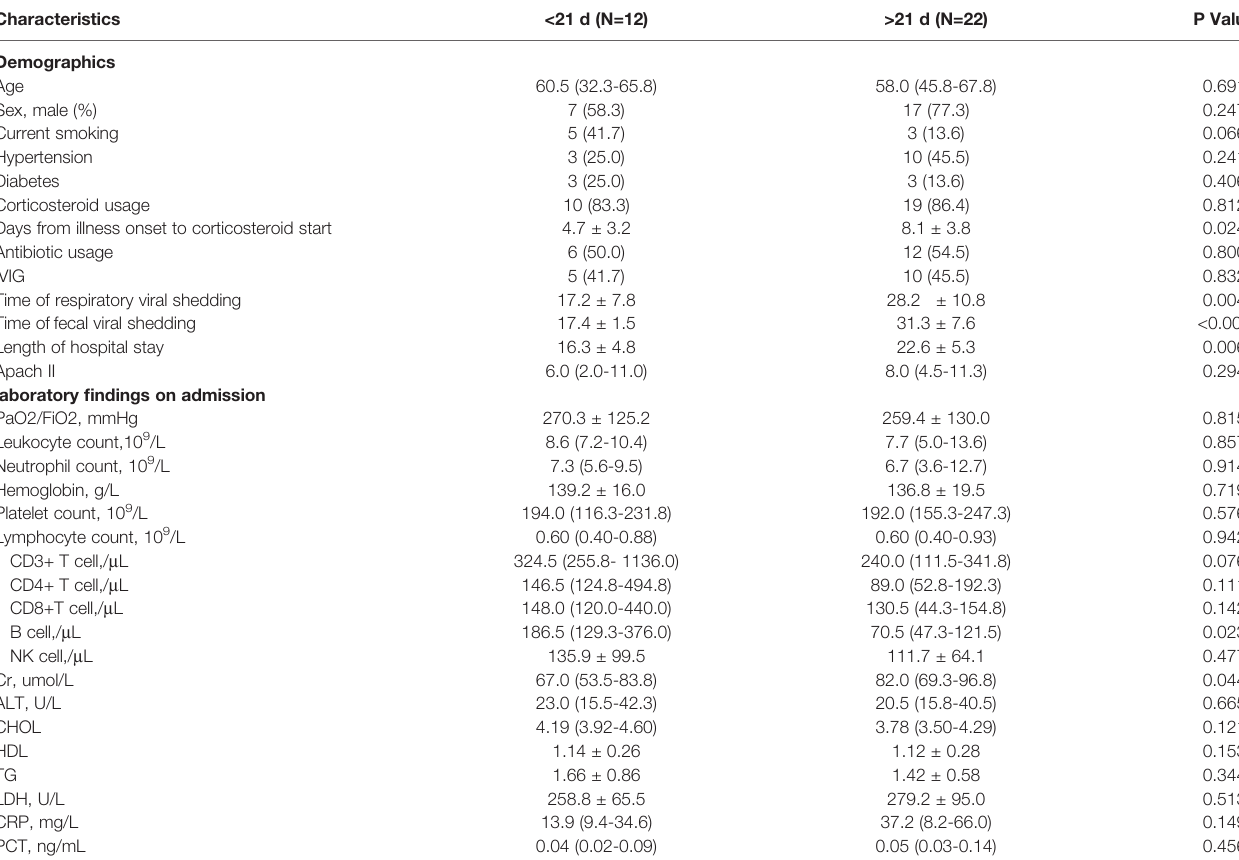
TABLE 3 | Factors associated length of fecal SARS-COV2 RNA shedding in the 34 patients. Characteristics